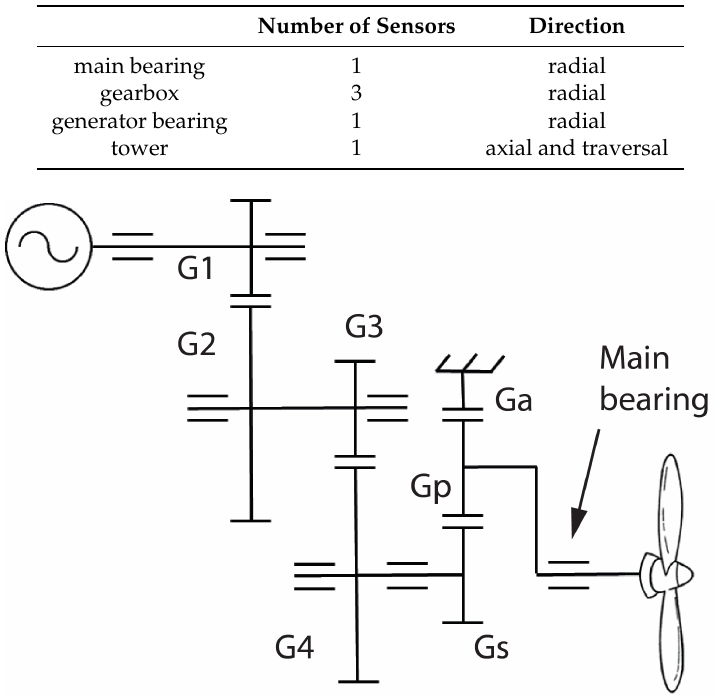
Figure 3. Schematic overview of the